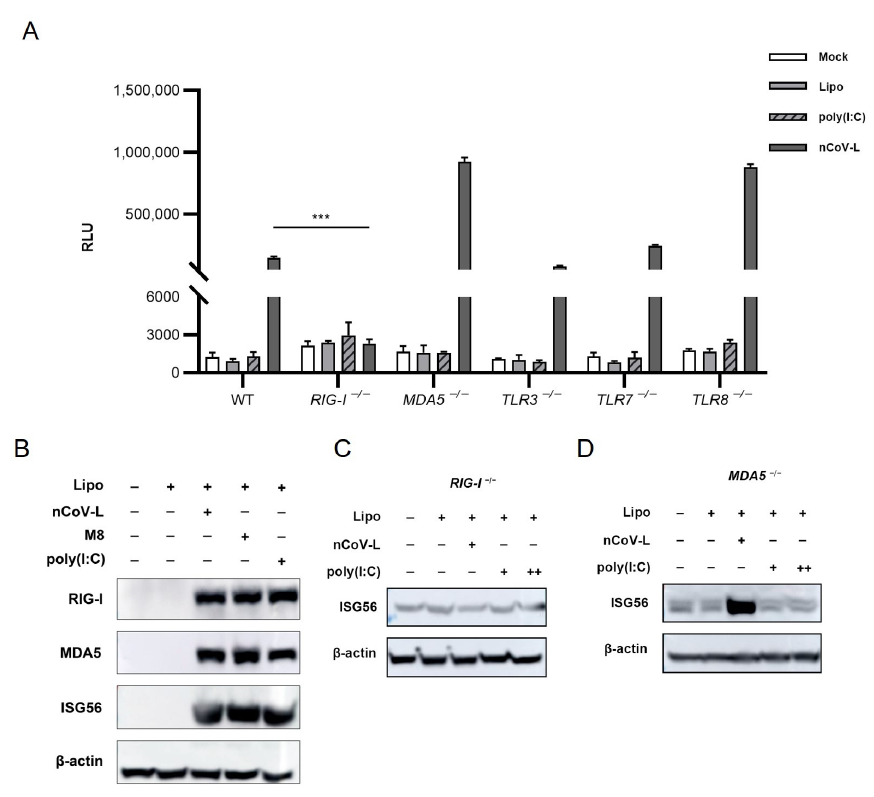
Figure A2. nCoV-L specifically activates the RIG-I receptor. ( A ) 1 × 10 4 wild-type (WT), RIG-I − / − ,